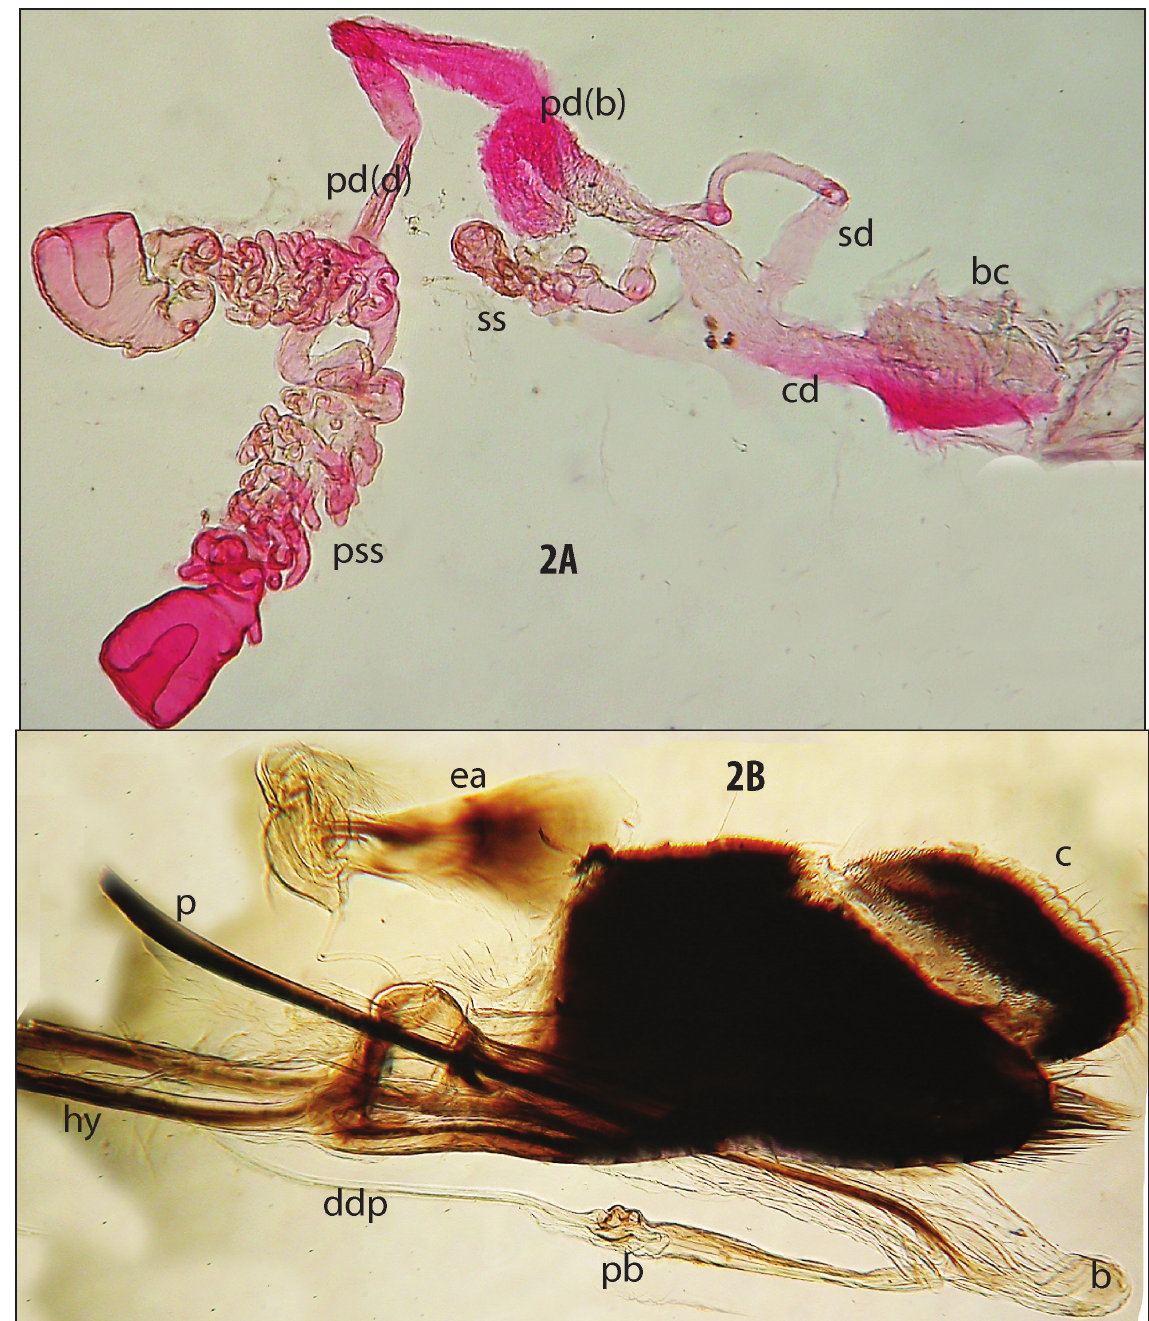
Fig. 2. Mesoconius albiseta sp. nov., internal characters. A . Spermatheca and associated structures. B . Male terminalia, left lateral. Abbreviations: b = basiphallus; bc = bursa copulatrix; c = cercus; cd = common duct; ddp = distal distiphallus; ea = ejaculatory apodeme; hyp = hypandrium; p = phallapodeme; pb = phallic bulb; pd(b) = paired spermathecal duct (basal section); pd(d) = paired spermathecal duct (distal section); pss = paired spermathecal stem; sd = single spermathecal duct; ss = single